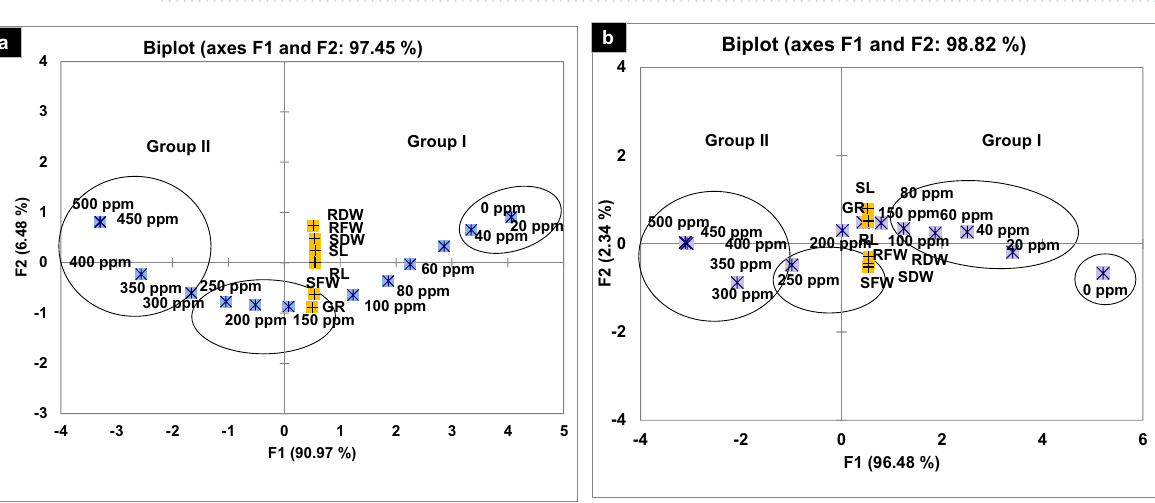
Figure 3. ( a and b ) Principal component analysis of germination, growth, and biomass due to the effect of 13 different concentrations of Cr(III) and Cr(VI) in Petri plate bioassays. GR Germination, SL shoot length, RL